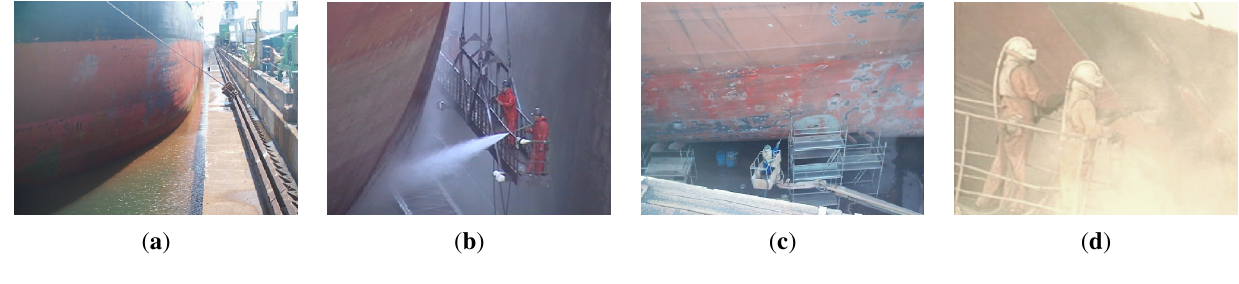
Figure 2. The maintenance works of a ship hull. ( a ) Beaching; ( b ) Ship Hull Desalination; ( c ) and ( d ) Grit-blasting cleaning